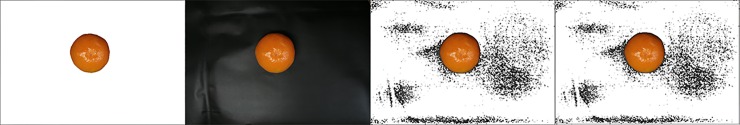
Foreground images segmented by different threshold values of coefficient of determination.